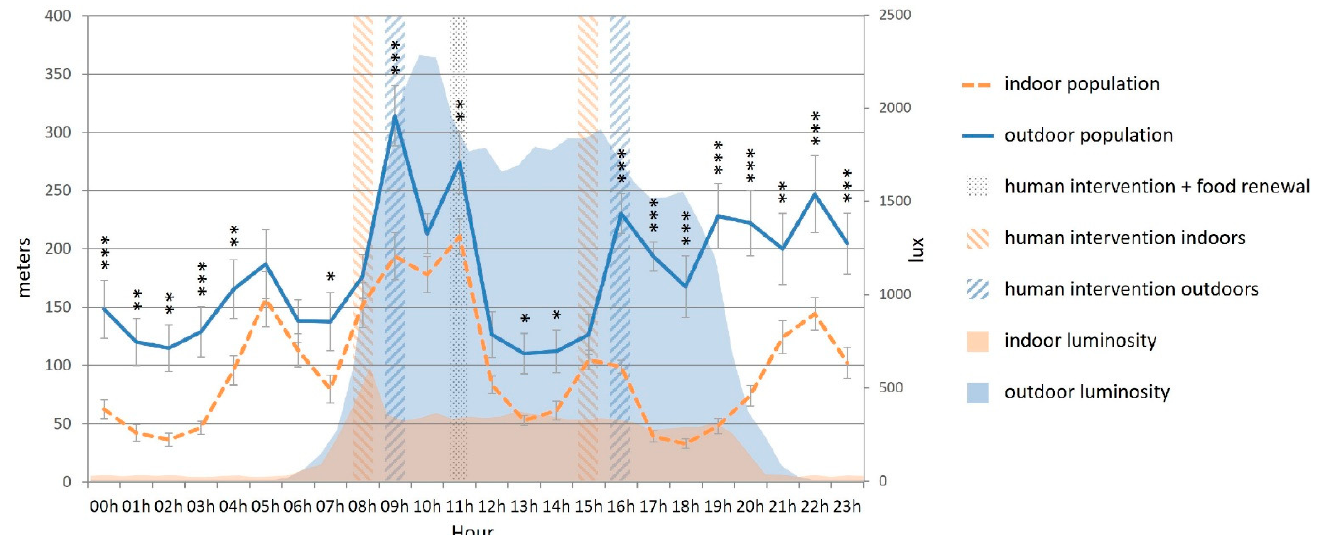
Figure 7. Mean covered distance (m, bars) and luminosity (lux, area) during a day cycle according to the housing condition of the cats (indoors (n = 15) vs. outdoors (n = 8)). Error bars represent standard errors, (*) indicates p < 0.05, (**) indicates p < 0.01, (***) indicates p < 0.001.